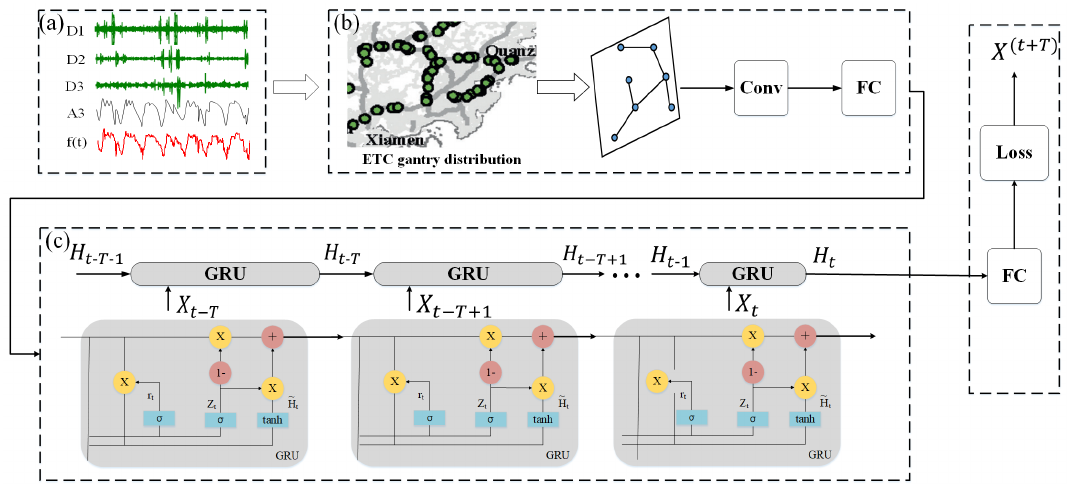
Figure 5. WSTGCN model.